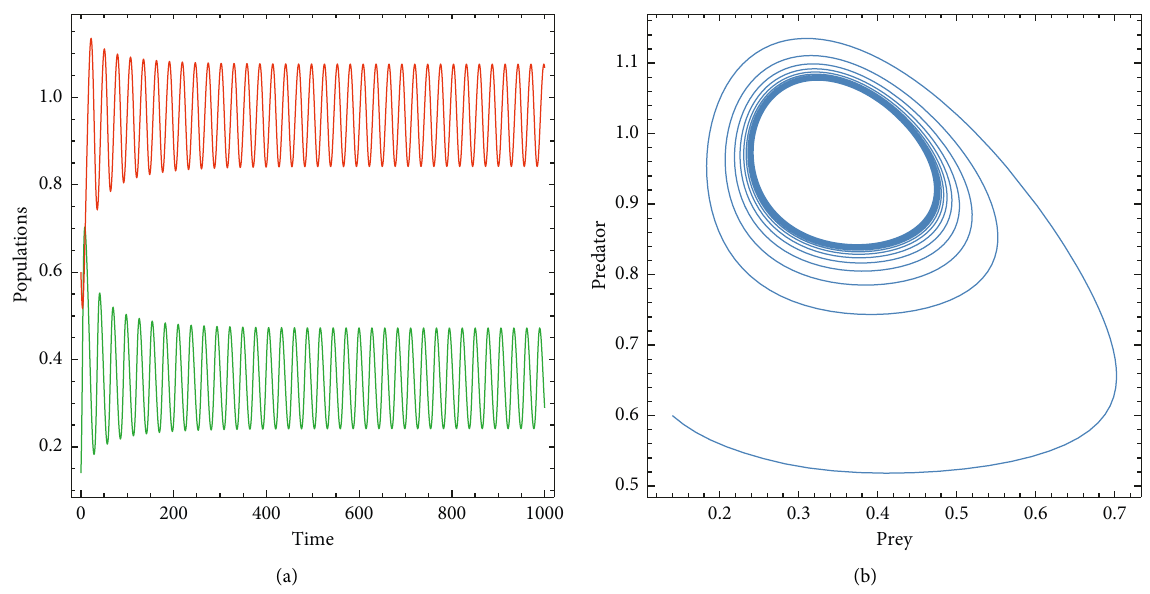
Figure 9: Periodic oscillations. (a) Time plot; (b) phase portrait for the model (52) with m